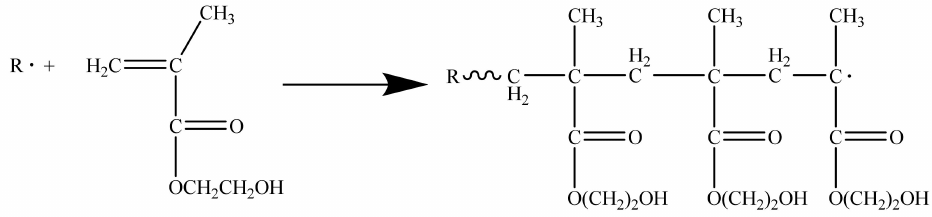
Figure 3. The polymerization reaction of 2-hydroxyethyl methacrylate to form the PHEMA